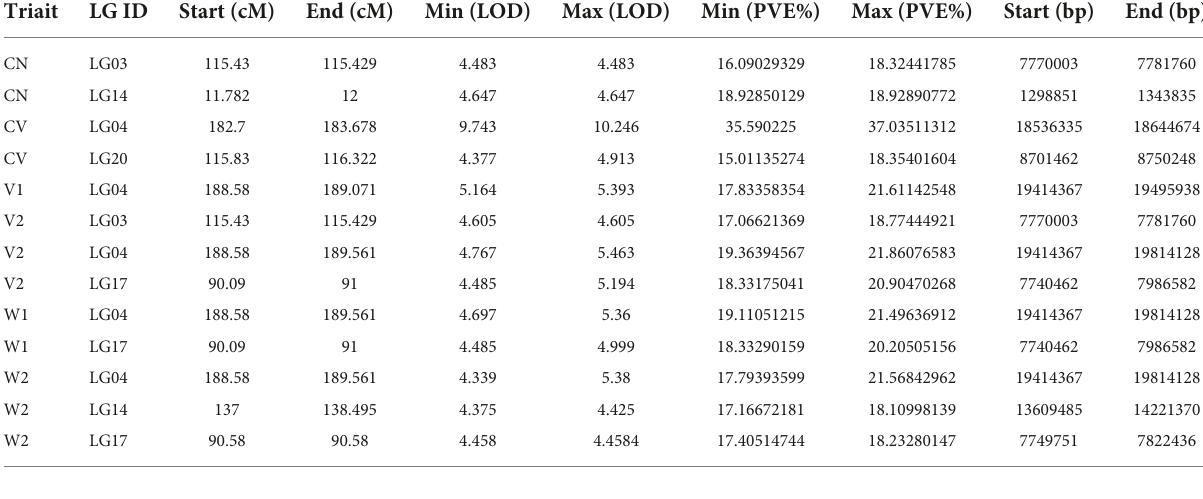
TABLE 2 Genetic mapping and quantitative trait locus analysis of 4 seed-related traits in 100 F 2 individuals.